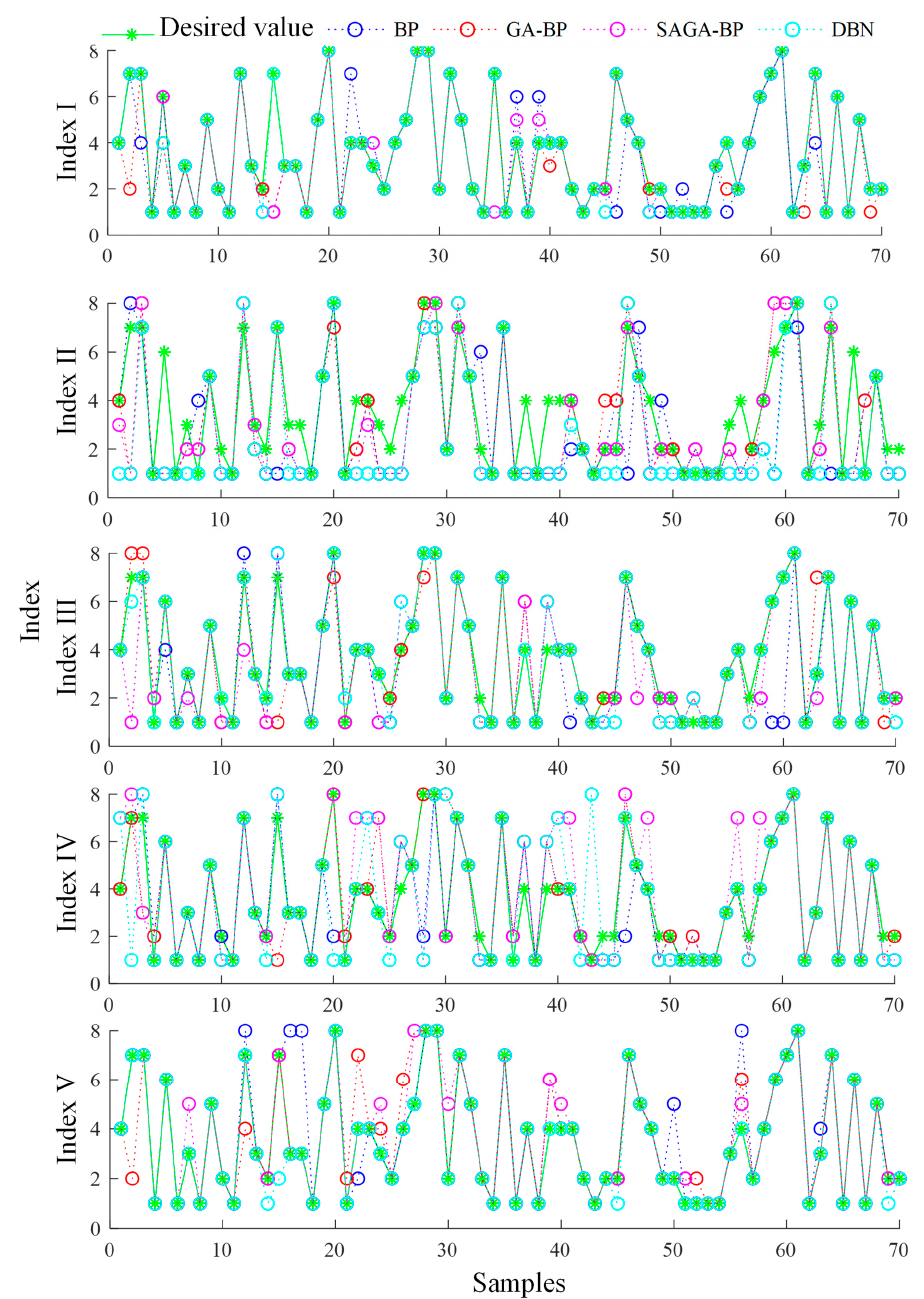
Figure 8. Pattern recognition results of different algorithms based on each index on an expressway.